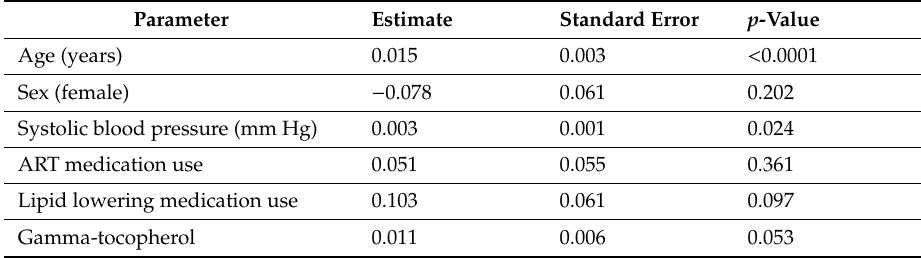
Table 4. Multivariate model of